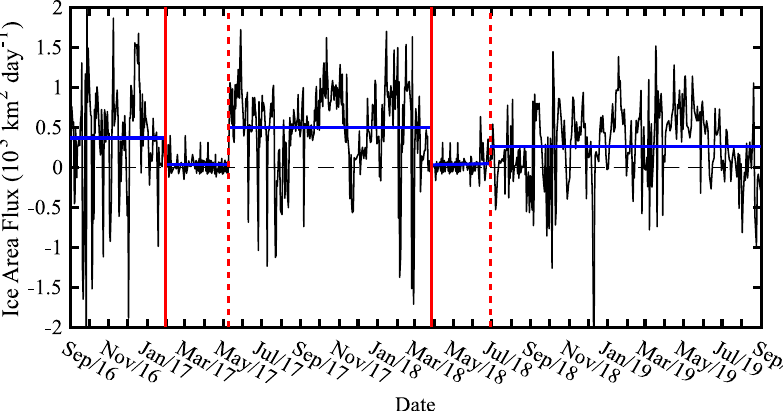
Fig. 3 Daily ice area fl ux (10 3 km 2 day -1 ) across the southern Lincoln Sea fl ux gate. The vertical solid red lines represent the best available estimates for the onset of the stoppage of ice motion along Nares Strait during 2017 and 2018 with the dashed red lines representing the best available estimate of the end of the stoppage during 2017 and 2018. The average ice area fl ux over various periods of interest are indicated by the blue lines. All data based on Sentinel-1 satellite-derived sea ice motion vectors. NATURE COMMUNICATIONS| (2021) 12:1 |https://doi.org/10.1038/s41467-020-20314-w|www.nature.com/naturecommunications